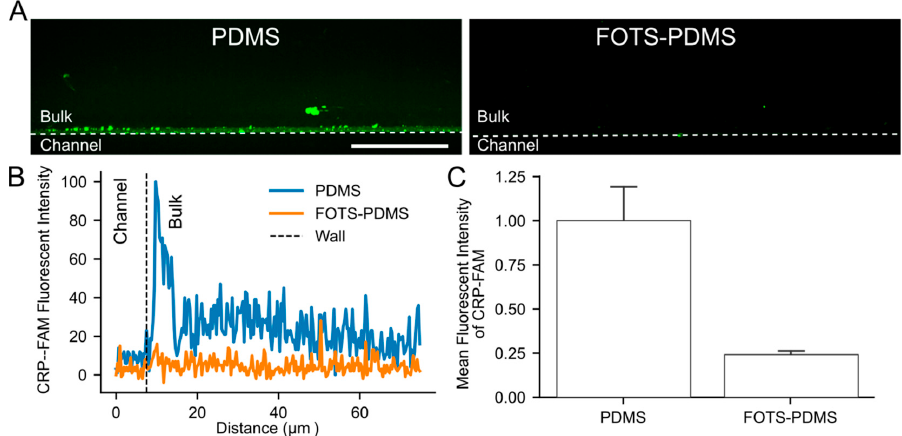
Figure 7. Collagen peptides are absorbed into PDMS but not FOTS-PDMS. ( A ) Representative images of absorption of CRP-FAM (750 µ g / mL) into PDMS and FOTS-PDMS following 2 h incubation. The wall of the channel is shown by the dashed white line. Scale bar = 50 µ m. ( B ) Line profile of fluorescence intensity showing penetration of CRP-FAM into PDMS and FOTS-PDMS. Dashed black line indicates the location of the channel wall. ( C ) Mean fluorescence intensity of residual CRP-FAM in the bulk of the materials (n = 4).